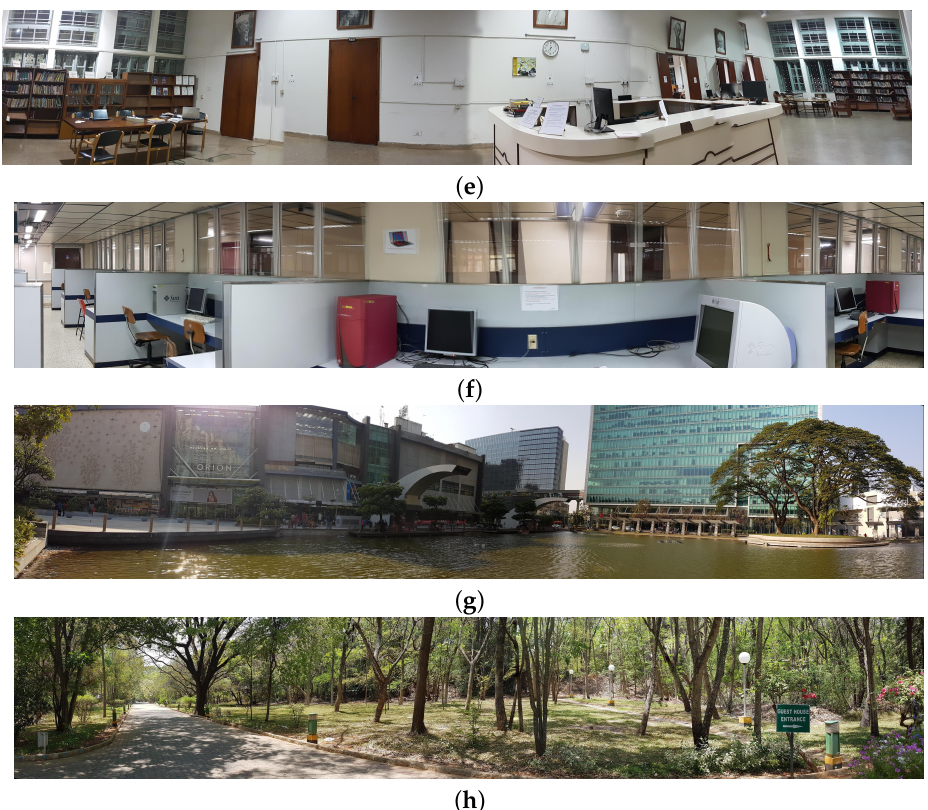
Figure 5. Sample images from the ISIQA database representing the outliers on the scatter plot for the SIQE metric presented in Figure 4a—from ( a – h ): no. 177, 182, 193, 168, 178, 194, 61, and